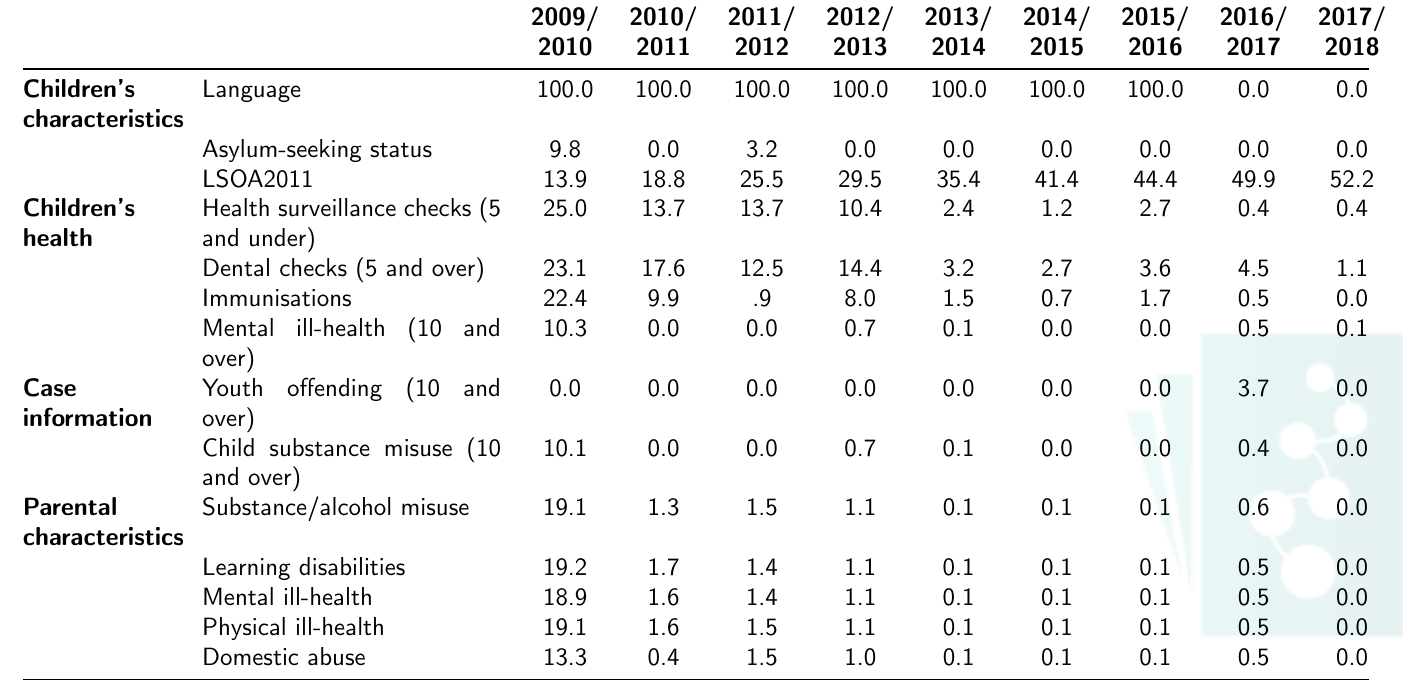
Table 7: The percentage of values either missing or entered as unknown for variables across the CIN and CRCS